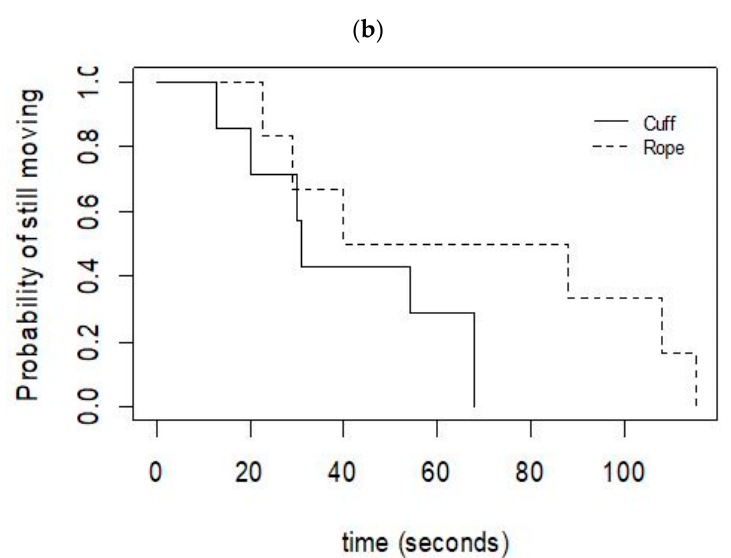
Figure 5. Kaplan–Meier graphs of ( a ) the latency to lose posture, and ( b ) the latency to cease moving in 16 calves that were successfully induced into a state of reduced responsiveness with either the cuff ( n = 8) or the rope ( n = 8).